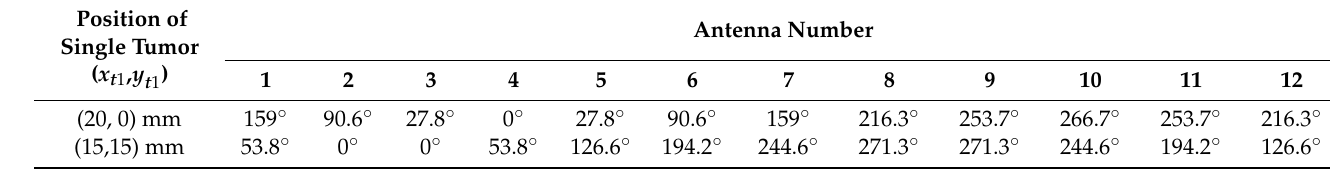
Table 2. Calculated input phases for unifocal breast